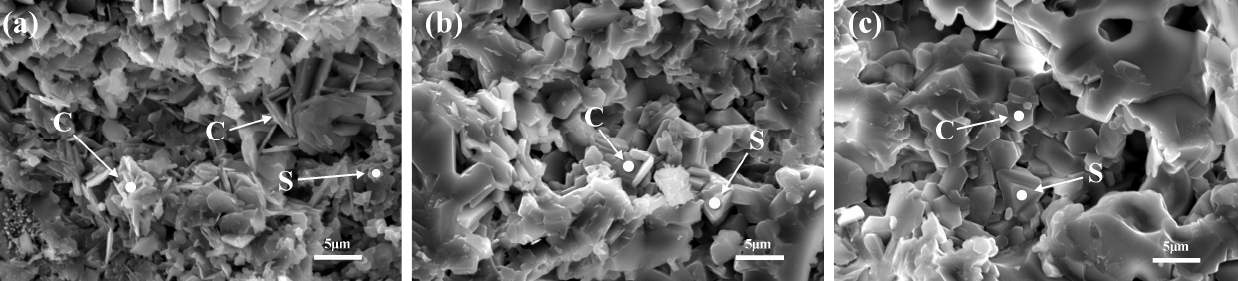
Figure 5. Microstructure of CA 6 (C) and spinel (S) in samples calcined at 1450 °C for 3 h: ( a ) MT2, ( b ) NT2, and (c) CT2. Table 3. EDS analysis of CA 6 and spinel in different samples calcined at 1450 °C for 5 h (at. %). Phase